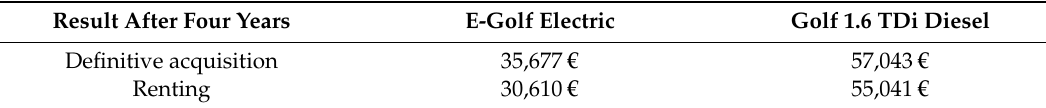
Table 2. Comparison between two light passenger vehicles.